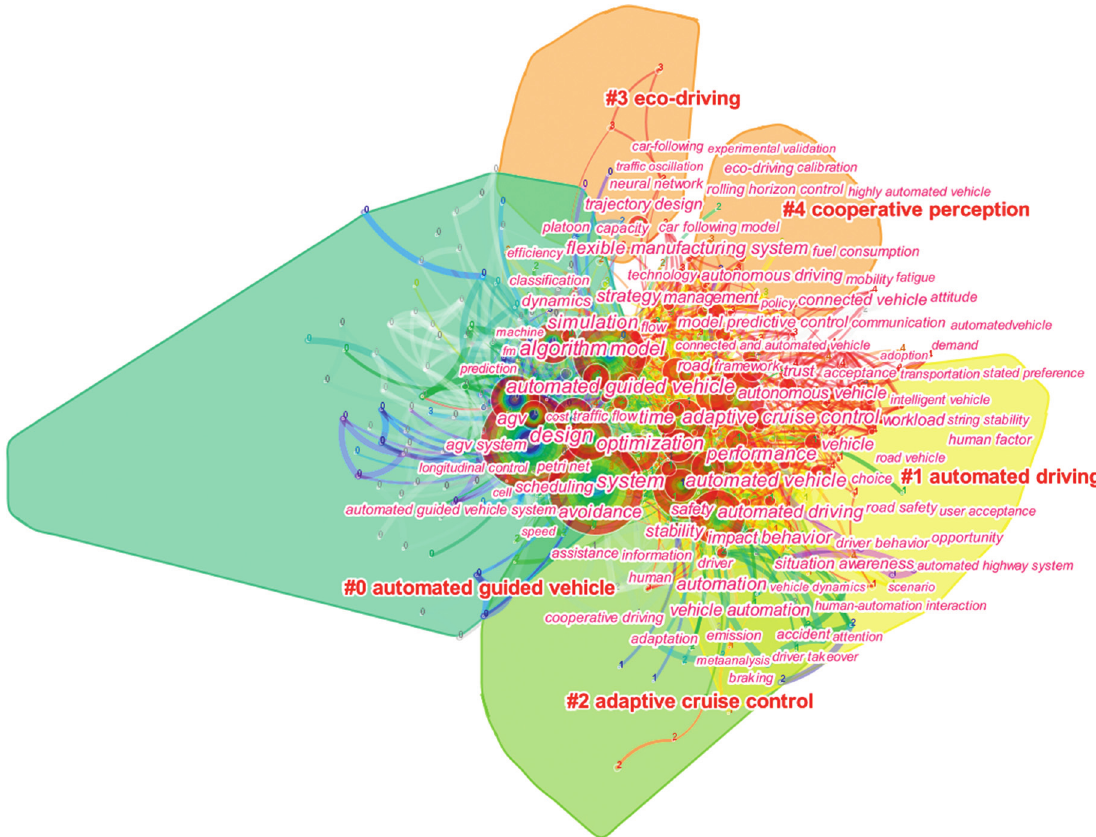
Figure 9: Keyword clustering